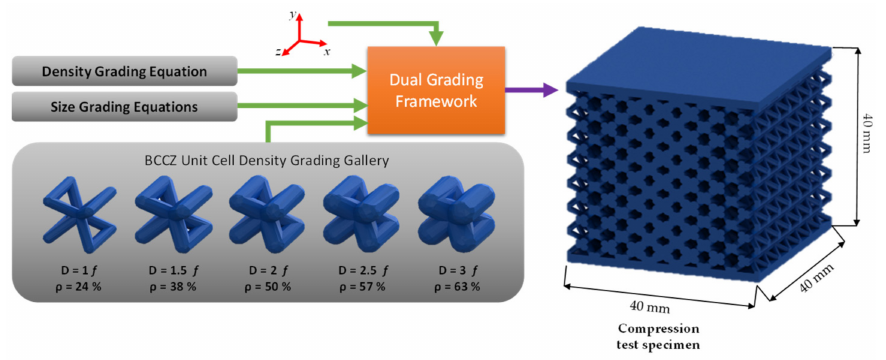
Figure 7. Generation of the dual graded lattice structure using a BCCZ grading gallery for compres- sion test